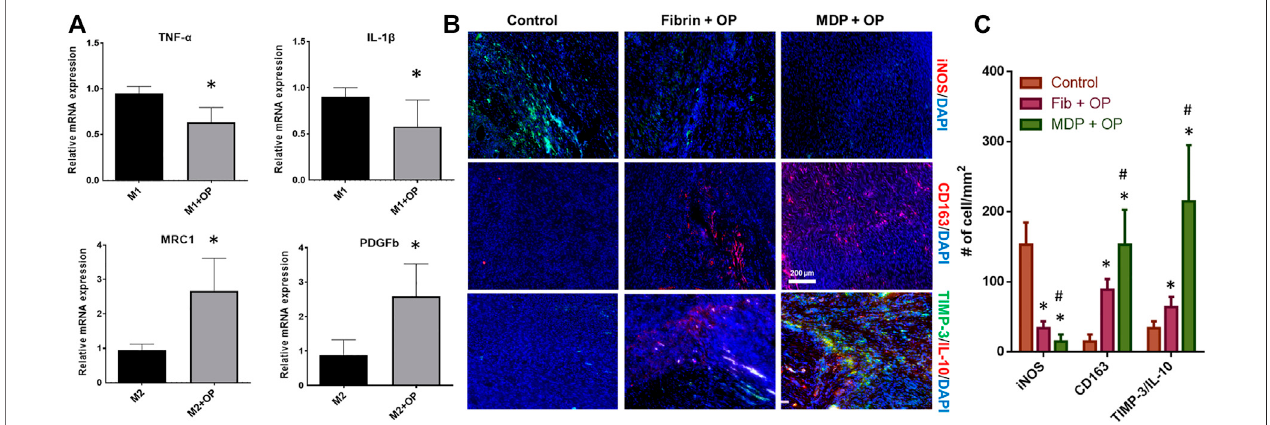
FIGURE 5 | Effect of Oxo-M and 4-PPBP on macrophage polarization (A) (*: p < 0.001 compared control). Immuno fl uorescence of macrophage and anti- in fl ammatorymarkers (B) .Quantitativeanalysisofcellnumbers (C) showedasigni fi cantlylowernumberofiNOS+M1-likemacrophagesOPdelivery.MDP+OPshowed anincreasednumberofCD163+M2-likecellsascomparedto fi brin+OP.TIMP-3andIL-10showedrobustexpressioninMDP+OPgroupincomparisonwithFib+OP ( n = 15 per group; *: p < 0.001 compared to control; #: p < 0.001 compared to Fib +